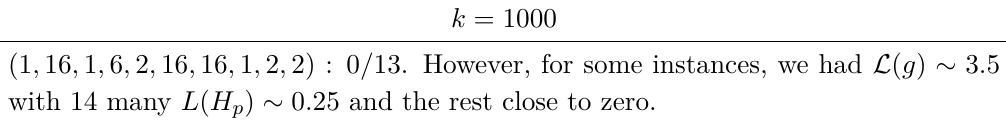
Table 2 . Kam ness for L 24 on su (8) .